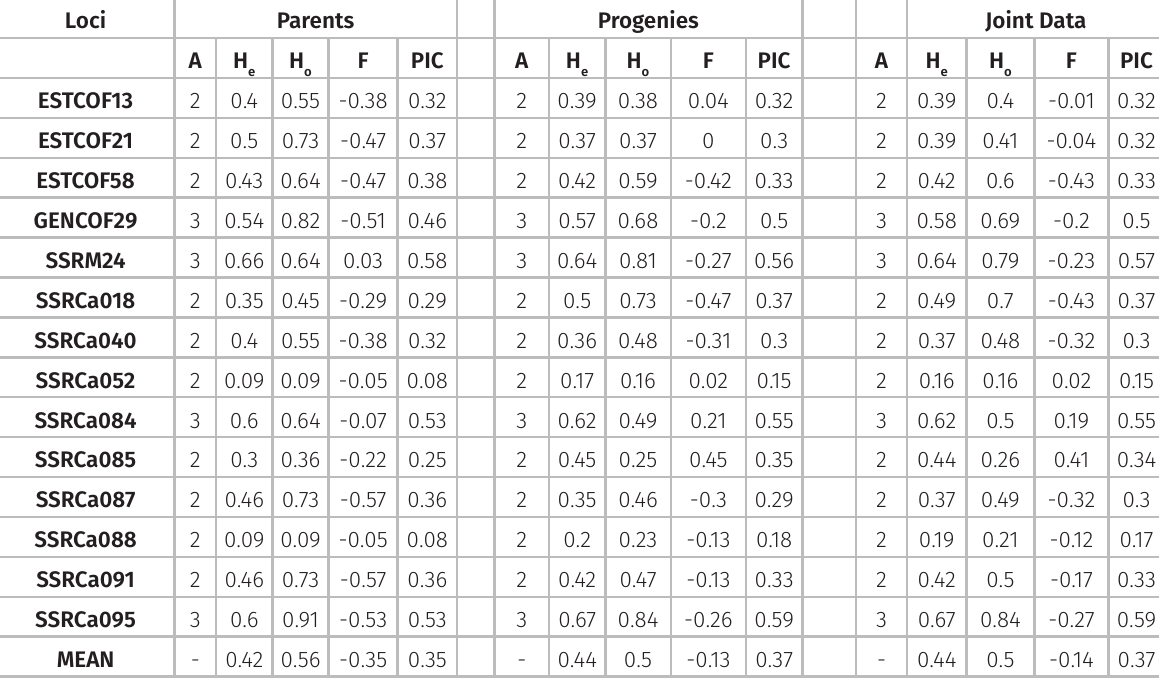
Table IV. Genetic parameters for each microsatellite locus evaluated in accessions of conilon coffee.